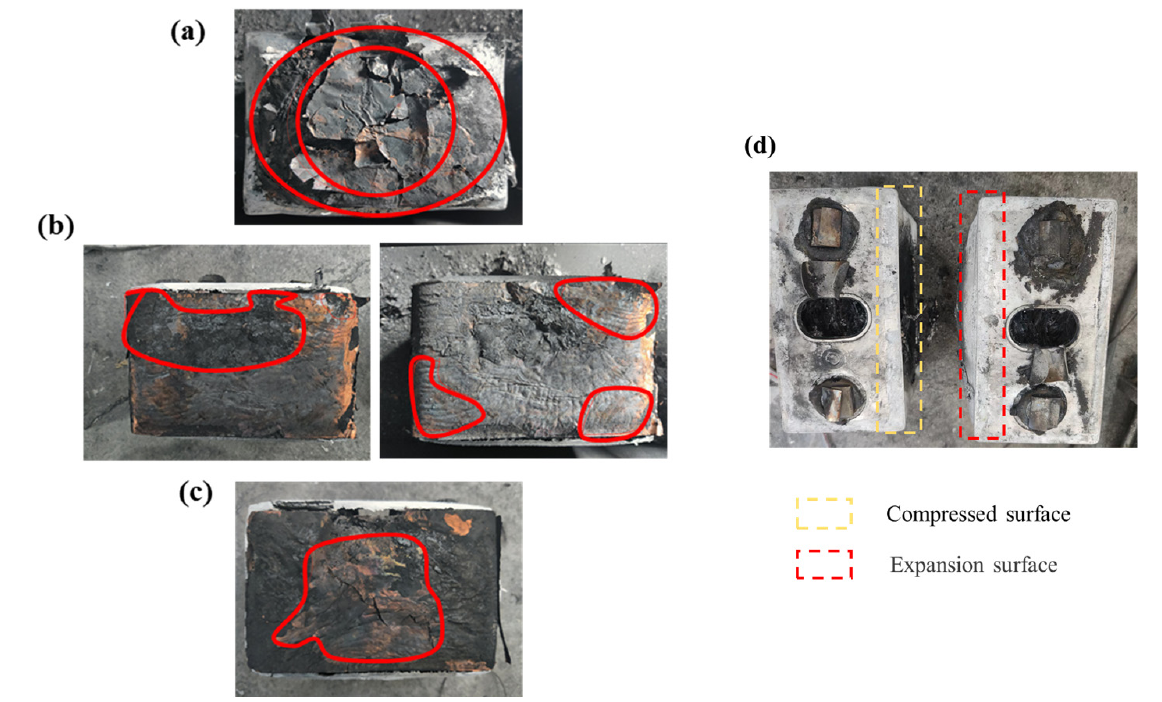
Figure 9. Battery wreckage: ( a ) test 1; ( b ) test 2; and ( c ) test 3. ( d ) Photos of battery surface after TR.